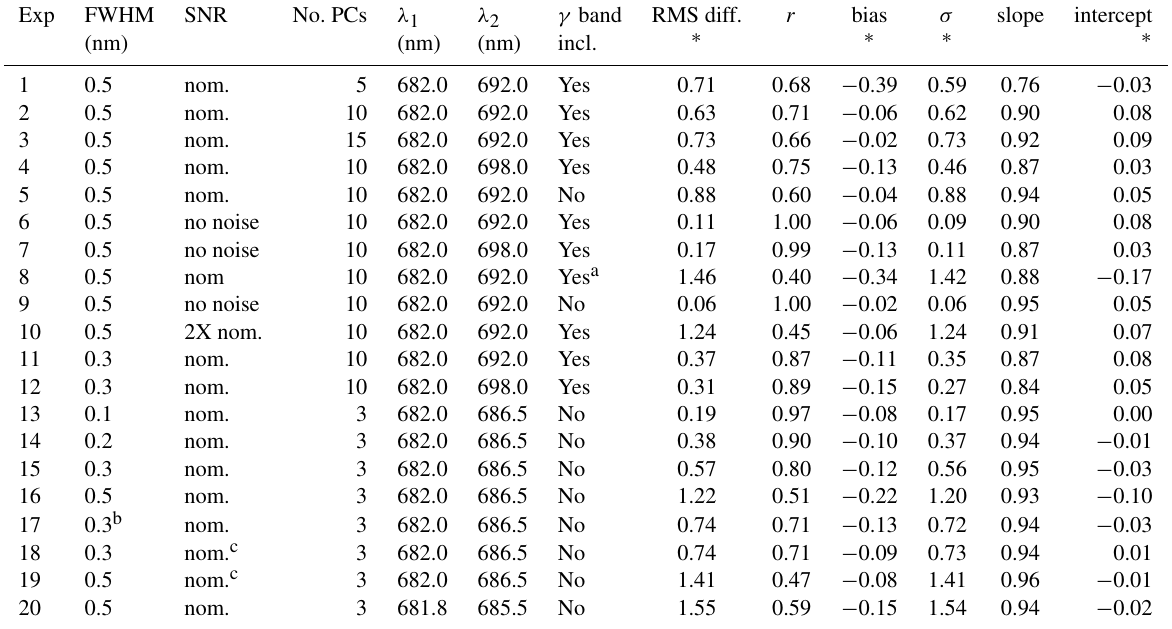
Table 1. Statistical comparison of retrieved versus “true” values of SIF obtained with the simulated testing data set for different experiments (Exp); all fluorescence radiance units (indicated by ∗ ) are mWm − 2 nm − 1 sr − 1 . Retrievals are performed for an instrument with a given full- width at half-maximum (FWHM) line shape function, signal-to-noise ratio (SNR), number of principal components (no. PCs), and fitting window from starting wavelength λ 1 to ending wavelength λ 2 . Statistics given are the root-mean-square difference (RMS diff.), correlation coefficient ( r ), mean difference (bias) of retrieved minus truth, standard deviation ( σ ), and slope ( B ) and intercept ( A ) of a linear fit (retrieved fluorescence = A + B · truth) (last two columns, respectively). Under the SNR heading, “nom.” refers to the nominal model described in